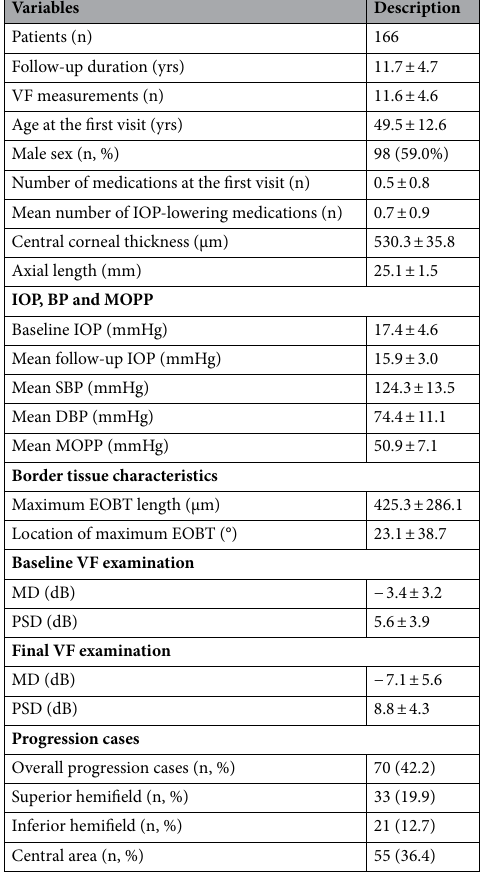
Table 1. Participant demographics and clinical characteristics. DBP diastolic blood pressure, EOBT externally oblique border tissue, IOP intraocular pressure, MD mean deviation, MOPP mean ocular perfusion pressure, PSD pattern standard deviation, SBP systolic blood pressure, VF visual field. Data are presented as the means ± standard deviations unless otherwise